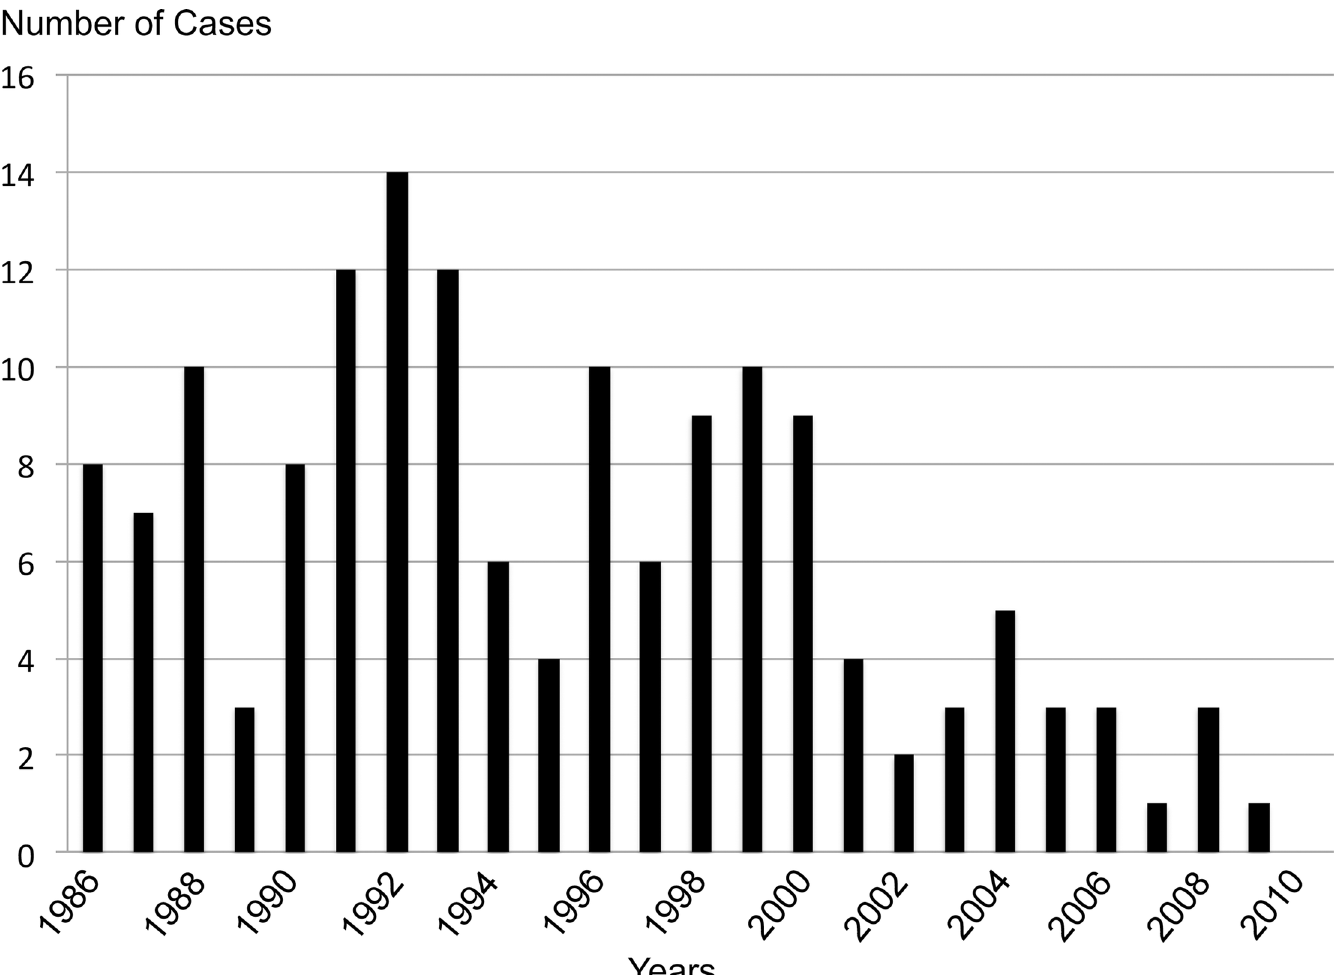
Fig 1. Number of HAM/TSP diagnosis per year over the 25-year study period.